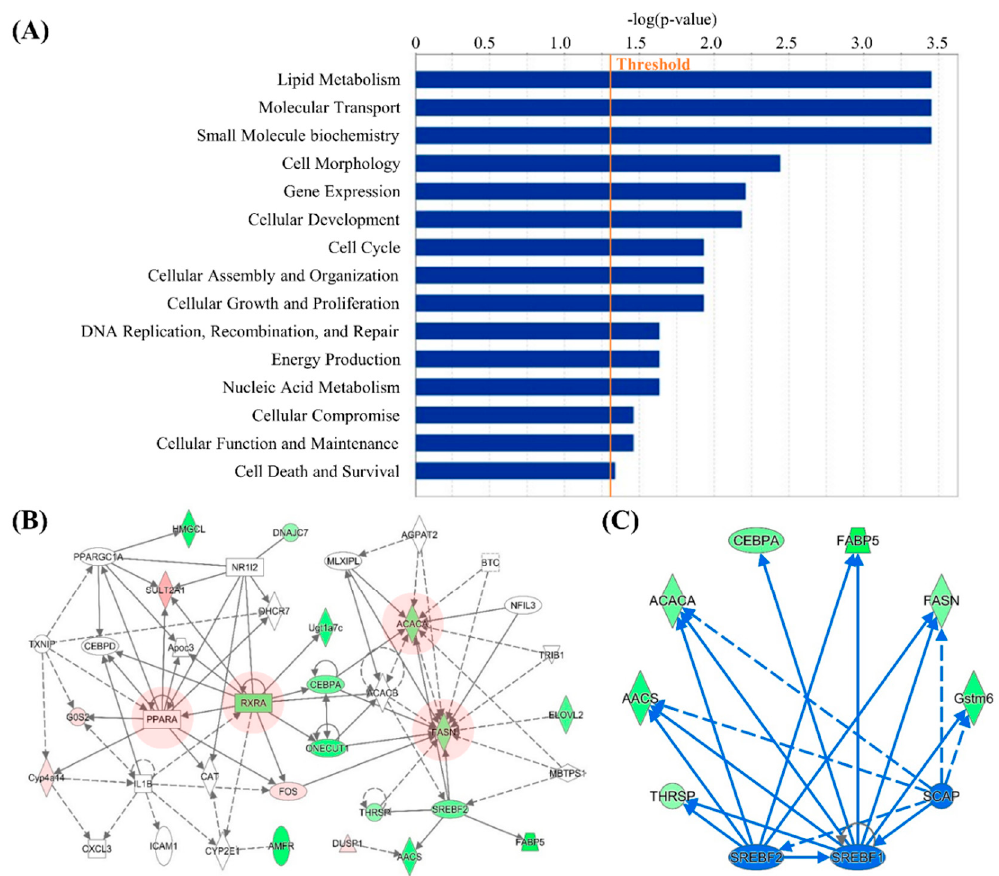
Figure 4. Biofunctions, networks, and upstream analyses using the Ingenuity Pathway Analysis (IPA). Enriched functional roles of networks in IDH2 KO mice are listed ( A ), and IPA Networks only related to lipid metabolism are integrated. The key transcripts at core position of the networks are highlighted with red color ( B ). Upstream regulators including Srebf1 , Srebf2 , and Scap , were predicted in the interactome image ( C ).